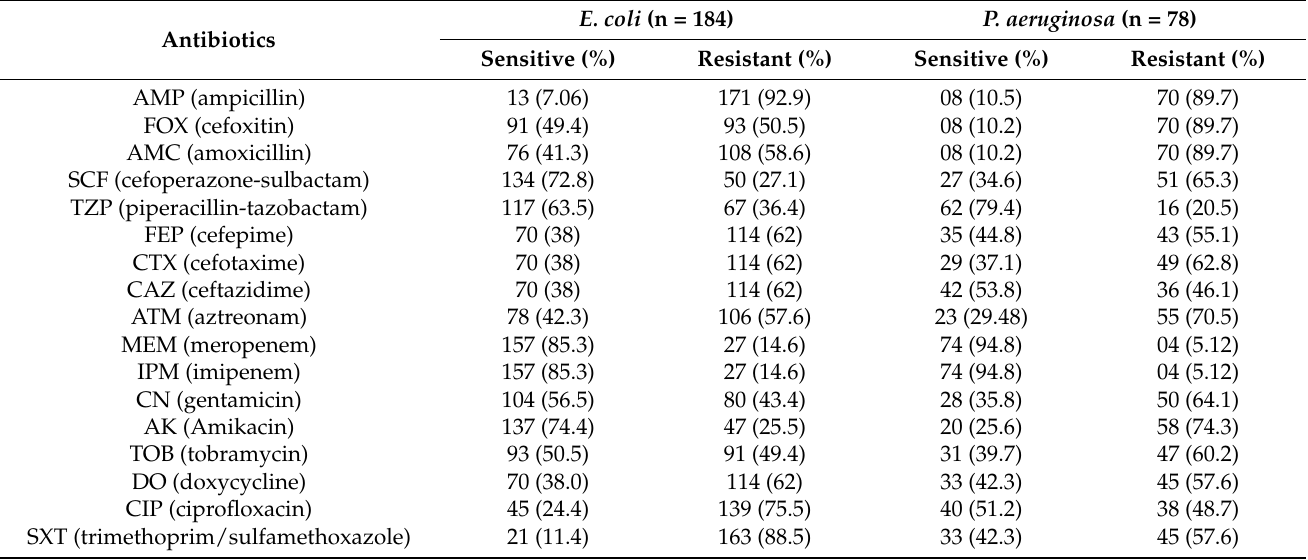
Table 2. Antibiotic susceptibility patterns of E. coli and P. aeruginosa against selected antibiotics.